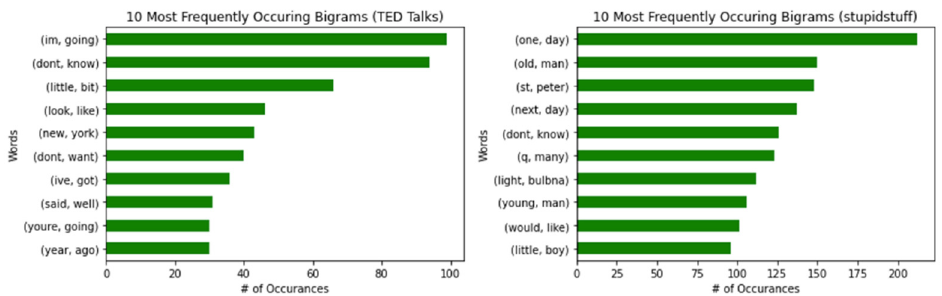
Figure 3. The 10 most frequently occurring bigrams for humorous sentences in TED Talks ( left ) and user-submitted jokes from stupidstuff.org ( right ).